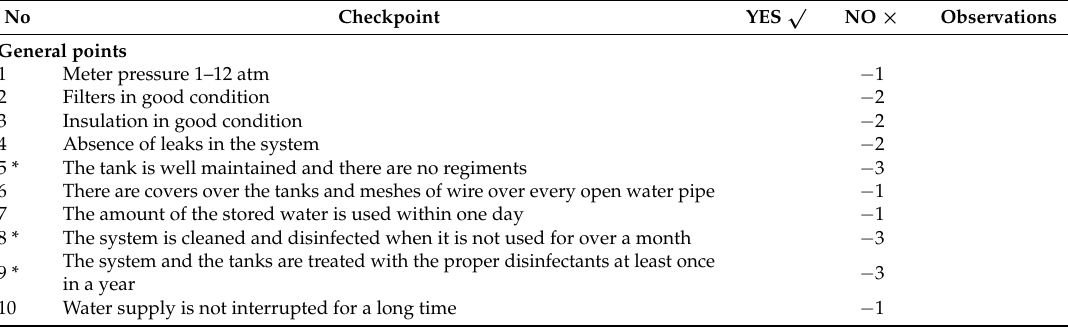
Table A1. Checklist used for standardized hygiene